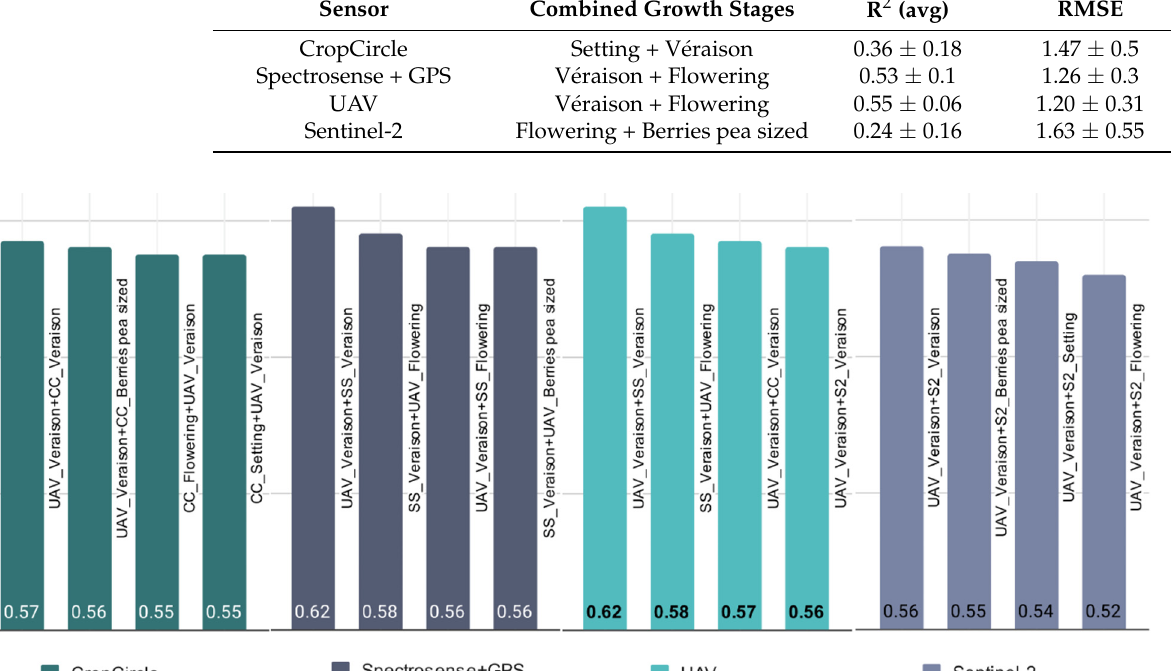
Table 7. Given a specific growth stage, the best combination of sensors and the corresponding best R2 over the two growing seasons (2019 and 2020), using AutoML to assess their performance in evaluating grape quality attributes (legend as for Table 2).